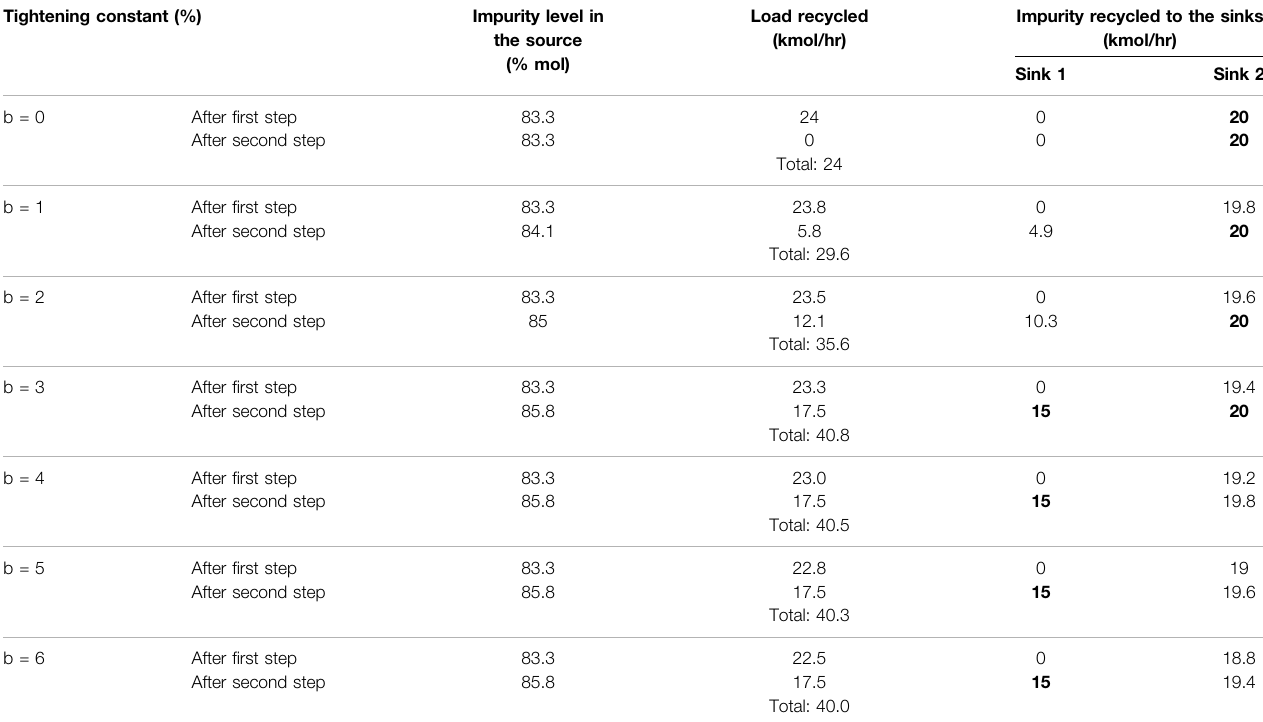
TABLE1| ResultsoftheMAItighteningandrelaxingapproachintheSMI RMP solutionprocedurefortheillustrativeexampleof Figure3 .Thehighlightedvaluesinboldreferto active MAI constraints. Tightening constant